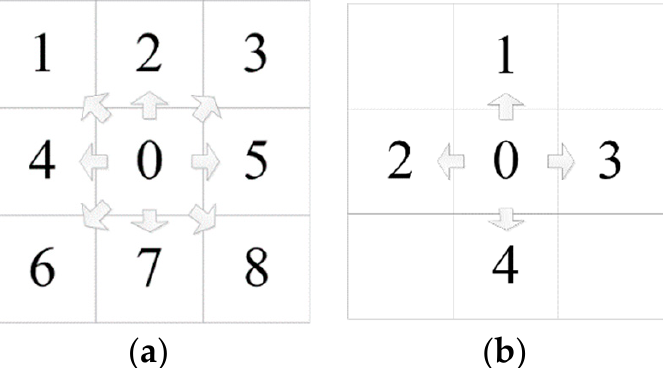
Figure 6. Two connection methods of the connected domain: ( a ) 8-connected mode and ( b ) 4-connected mode. The number “0” represents the central pixel, the other numbers are its adjacent pixels, and the arrow represents its azimuth